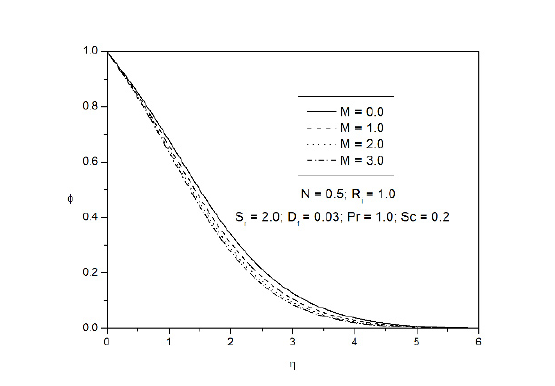
Figure 6. Effect of mixed convection parameter R Rate